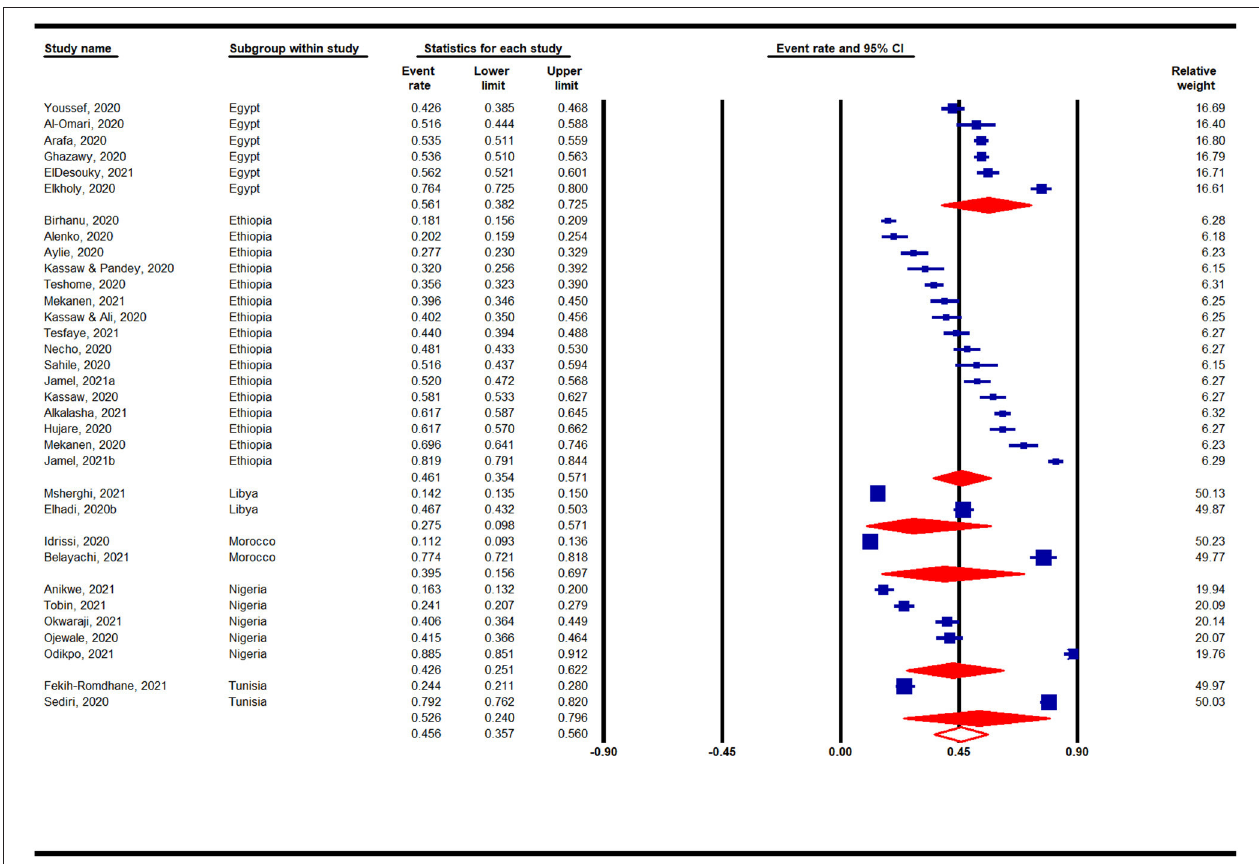
FIGURE 4 | Prevalence of anxiety in Africa by countries during the COVID-19 pandemic.